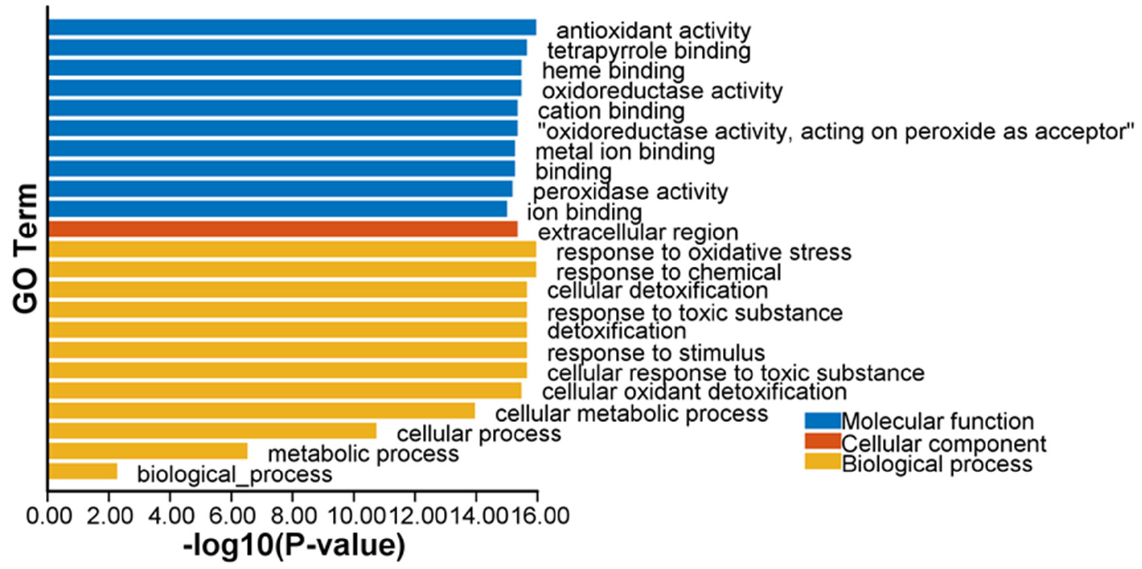
Figure 6. GO enrichment analysis of ClPRXs in watermelon.